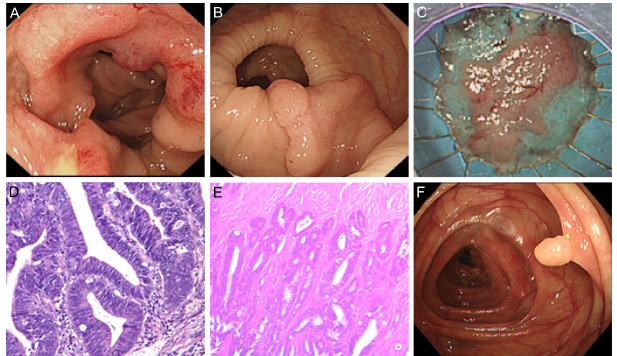
Figure 2. Surgical resection for colon tumor and ESD for LST in 1 SCRC patient. A male patient, 70 years old. (A) 4 × 5 cm mass was observed in hepatic flexure. (B) A 3.0 cm × 2.0 cm LST was observed in splenic flexure under the endoscope; (C) ESD of the LST with Dualknife before surgery, and the specimen was paved; (D) The LST’s pathology shows high-grade intraepithelial neoplasia and focal canceration with negative horizontal resection margins. (E) Ten days after ESD, the hepatic flexure mass was resected under surgery, and its postoperative pathologyshows moderately differentiated adenocarcinoma. (F) A 0.6 × 0.6 cm polyp were observed in survelliance colonoscopy, pathology diagnosed as tubular adenoma. ESD, endoscopic submucosal dissection; LST, laterally spreading tumor; SCRC, synchronous colorectal cancer.